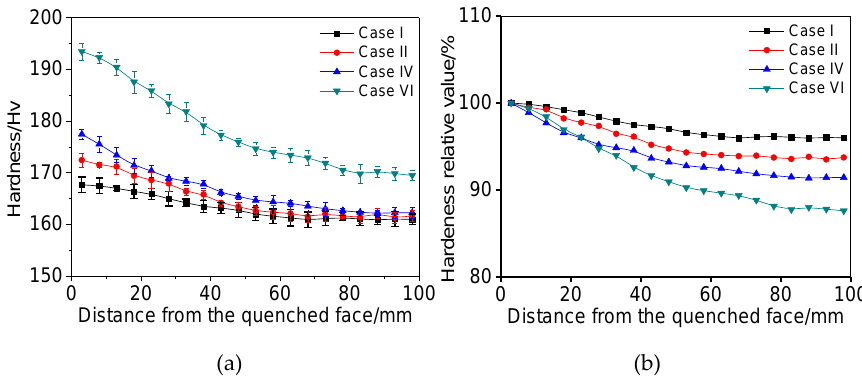
Figure 3. Relationships of ( a ) hardness vs. distance from the water-quenching ends and ( b ) hardness retention value vs. distance from the water-quenching ends.